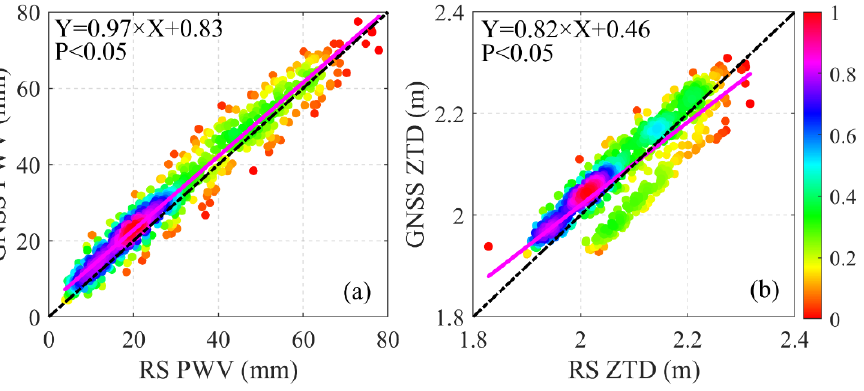
Figure 3. Precision comparison of GNSS-derived and RS-derived PWV and ZTD, where ( a ) is the comparison of GNSS- and RS-derived PWV while ( b ) is the comparison of GNSS- and RS-derived ZTD.